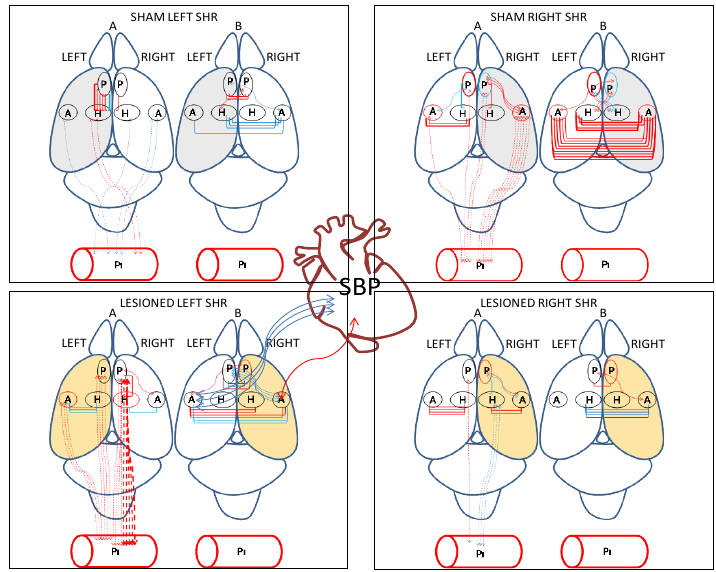
Figure 5. Schematic representation of the observed significant correlations: between brain ami- nopeptidase activities; between plasma aminopeptidase activities versus brain aminopeptidase ac- tivities; between brain aminopeptidase activities versus systolic blood pressure (SBP) in the four groups studied of spontaneously hypertensive rats. Positive correlations in red and negative cor- relations in blue. Continue lines: significant correlations between brain locations and between brain versus SBP. Dotted lines: significant correlations between brain versus plasma. The thickness of lines is proportional to the degree of significance. Above rat brain: A, intra-hemispheric and brain vs. plasma correlations, B, inter-hemispheric correlations. The hemisphere was injected with saline for sham animals in grey. The hemisphere was injected with 6-OHDA for lesioned animals in light orange. P, medial prefrontal cortex; A, amygdala; H, hippocampus; Pl, plasma.